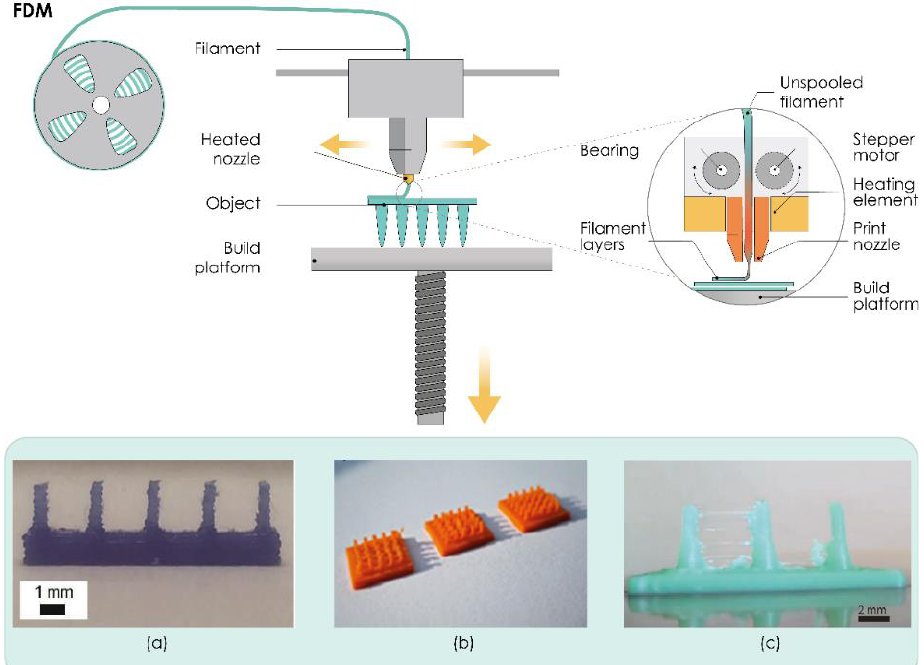
Figure 2. The working principle of fused deposition modeling (FDM). ( a – c ) Microneedles produced by FDM technology. Reproduced with permission from [26,32,117], Royal Society of Chemistry, London, UK, 2018 ( a ), Springer Nature, Basingstoke, UK, 2020 ( b ), and John/Wiley & Sons, Inc., Hoboken, NJ, USA, 2020 ( c ). The image was created with Adobe Illustrator CC (Version 23.0.1.; Adobe Inc., San Jose, CA, USA, 2019).